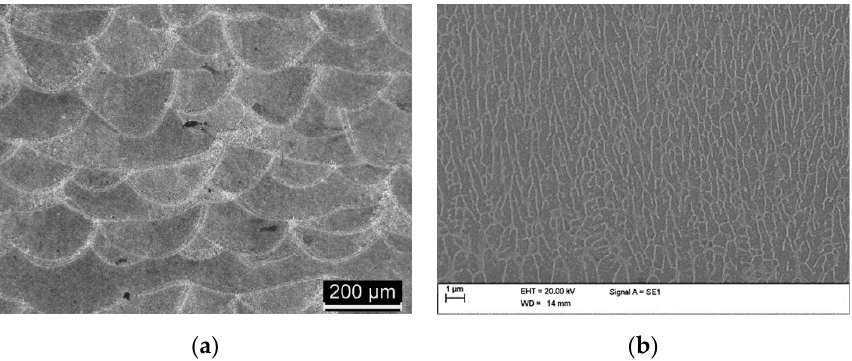
Figure 2. Microstructural analysis: ( a ) Optical microscope and ( b ) scanning electron microscope (SEM) micrographs of as-built specimen observed in the xz view.